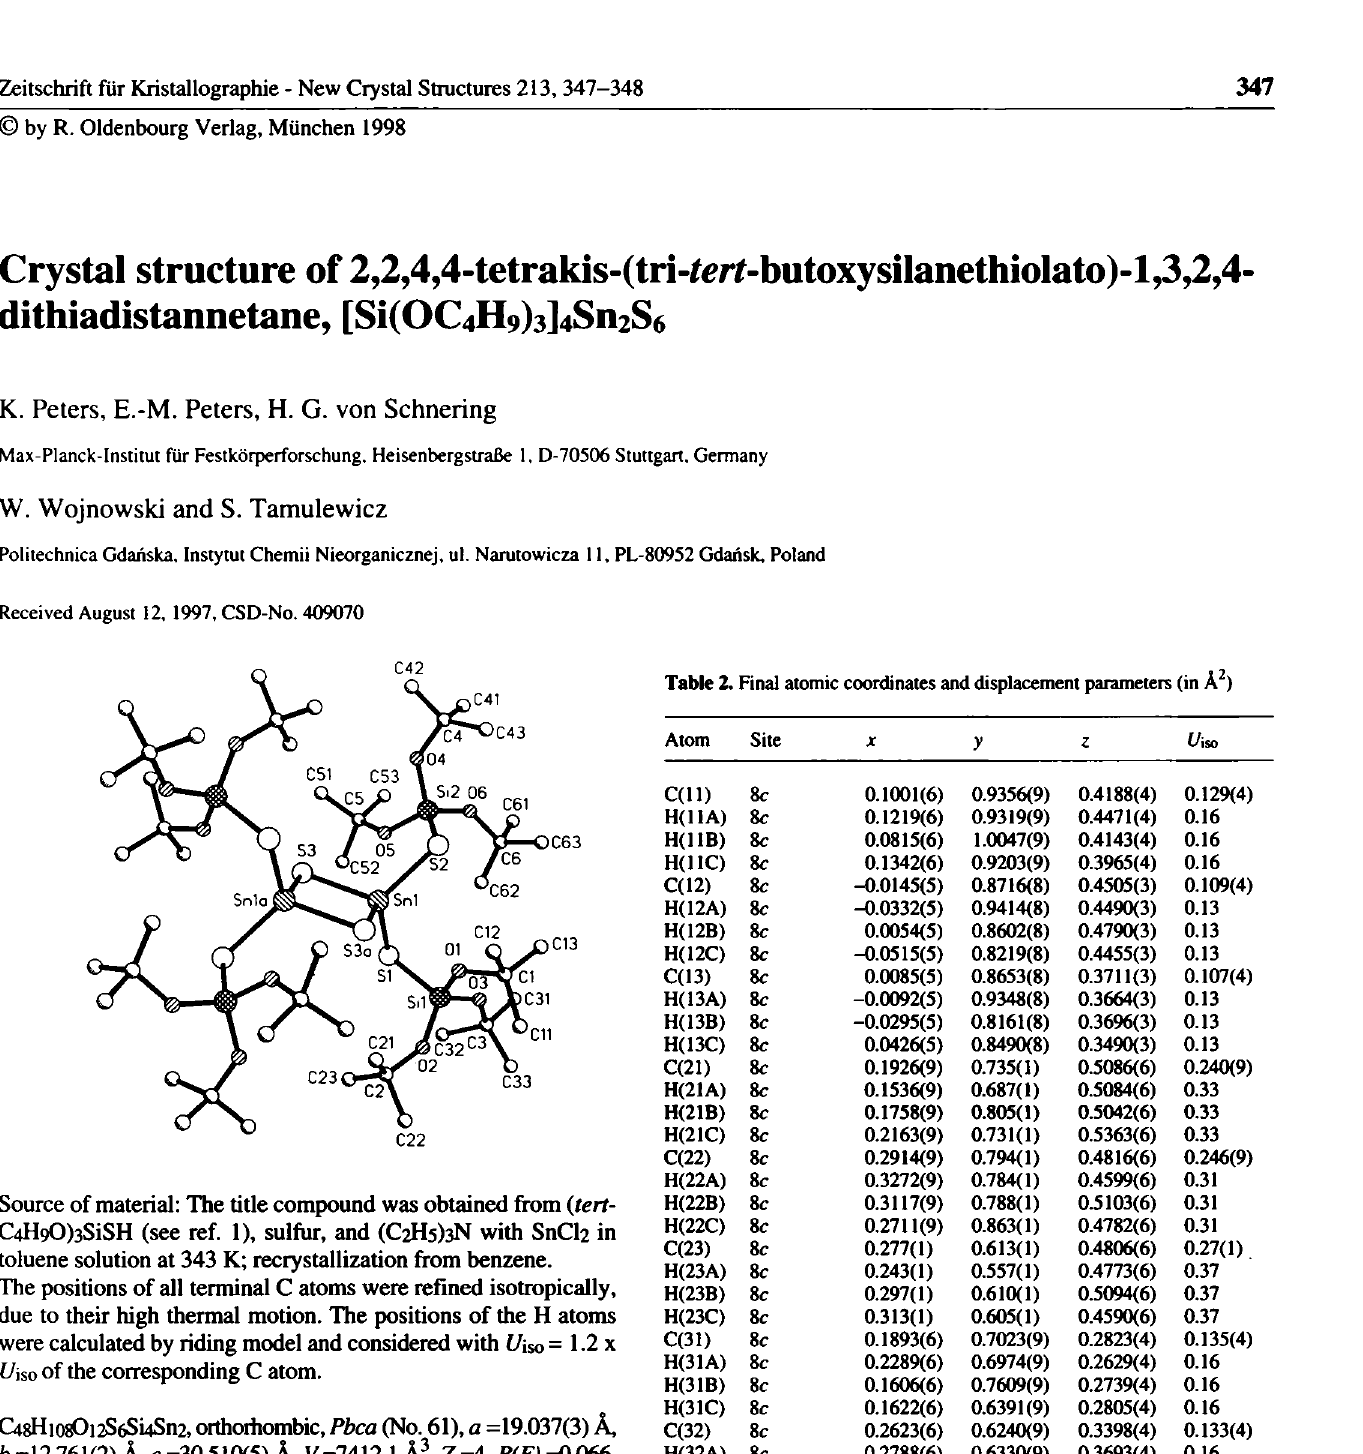
Table 1. Parameters used for the X-ray data collection Crystal: